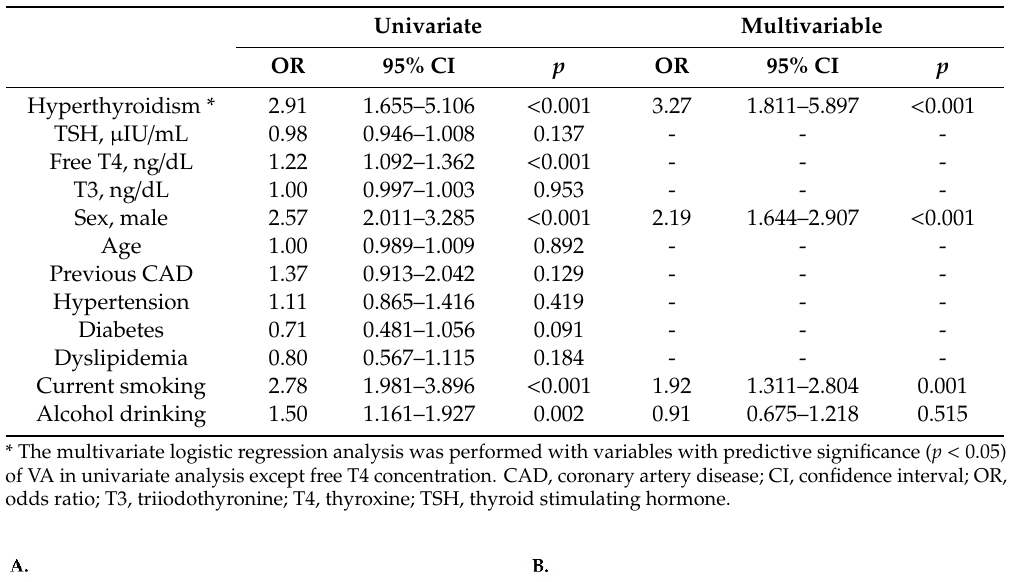
Table 2. Predictors of Vasospastic Angina.